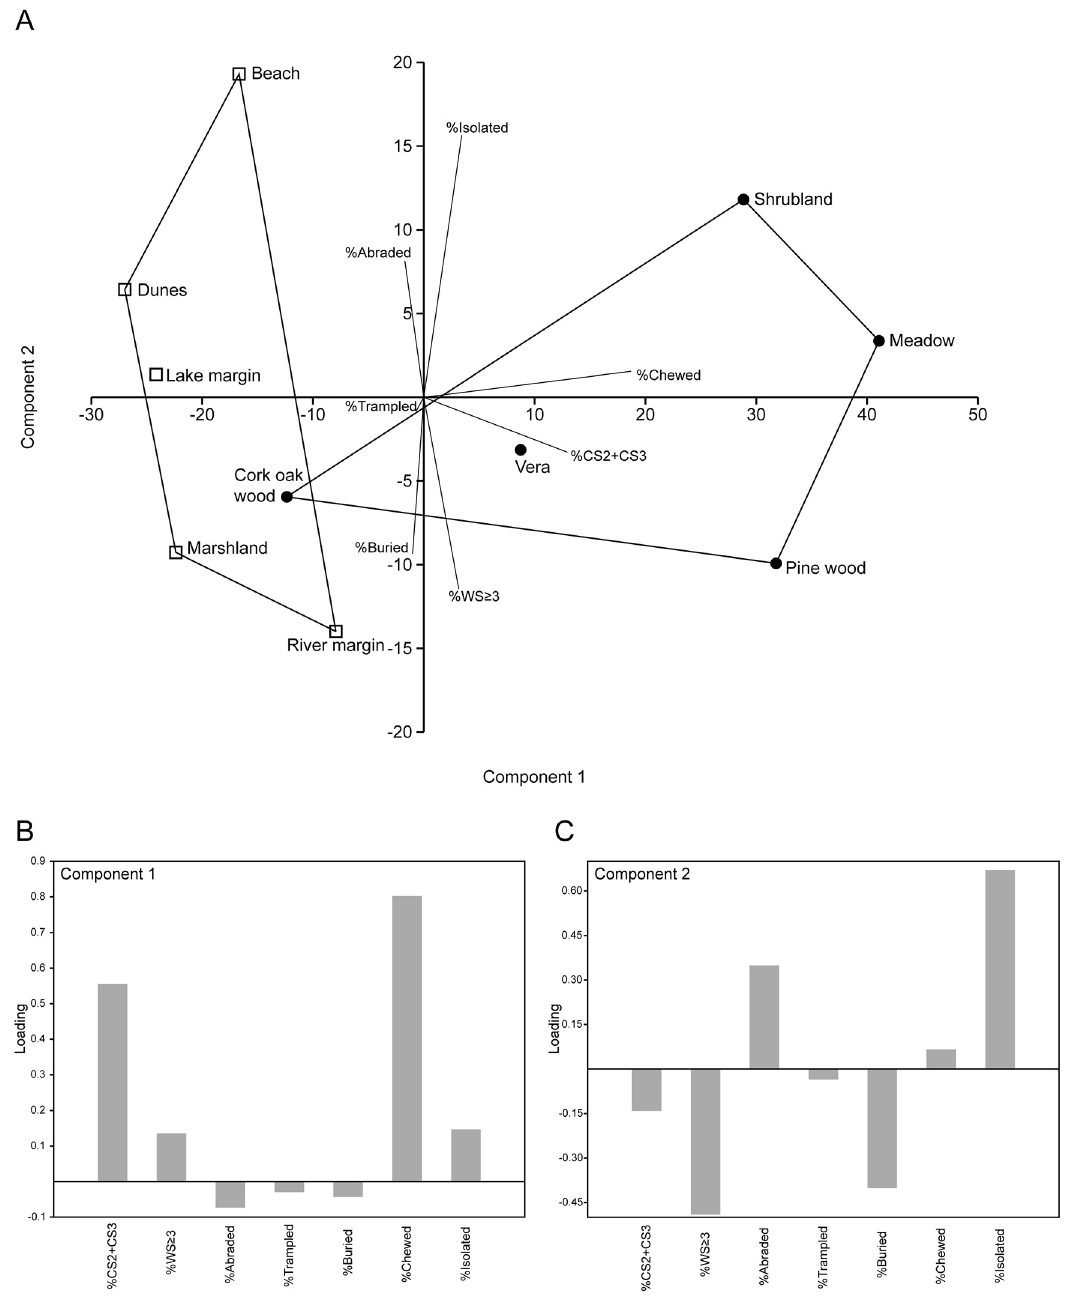
Fig 3. Principal Component Analysis (PCA) of the ten habitats as a function of their taphonomic variables. (A) PCA biplot showing the two first principal components (PC1 and PC2); active depositional environments represented by squares; the other habitats are indicated by circles; the correlation of each variable with each axis is indicated by the length and angle of line segments. (B) PC1 loadings; CS = completeness stage; WS = weathering stage. (C) PC2 loadings. and the presence of chewing marks, separating at one end of the axis the habitats with more breakage (%CS2+CS3) and chewed bones from the habitats with less breakage and fewer chewed bones at the other end (Fig 3A and 3B). The most important variables for PC2 are iso- lated bones, at one end of the axis, and the proportion of articulated+associated bones, at the